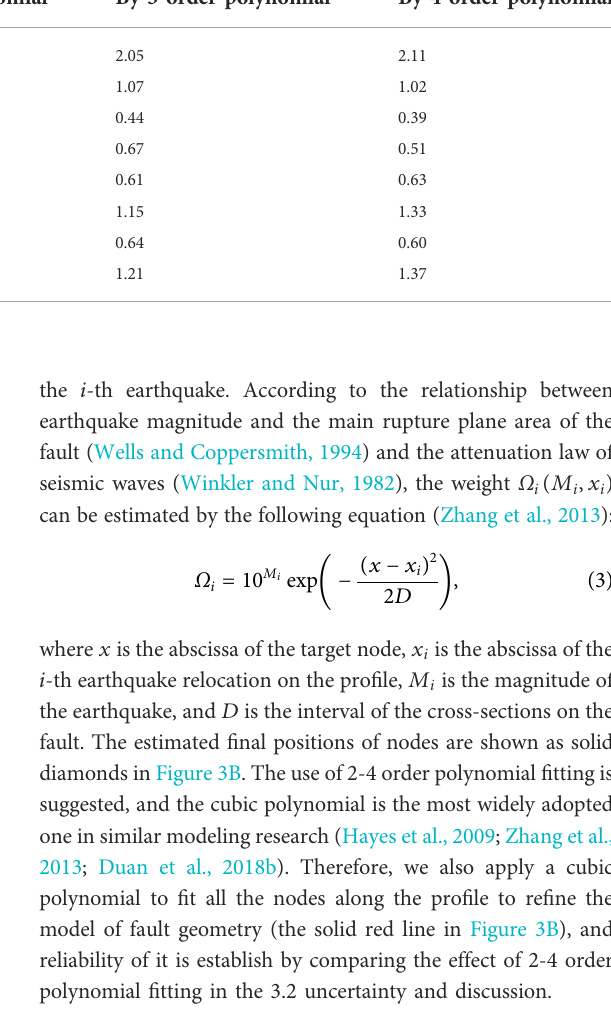
TABLE 3 The RMSE between the geophysical interpretation results and the fi tting results based on 2 − 4 order polynomialby the method of this study. Pro fi le index Fault name RMSE of the ruptured seismogenic fault models/km By 2 order polynomial By 3 order polynomial By 4 order polynomial